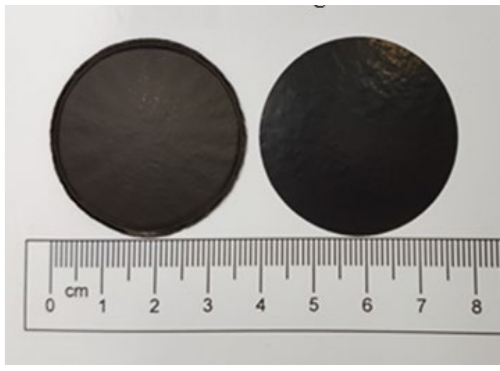
Figure 3. Buckypapers as prepared.